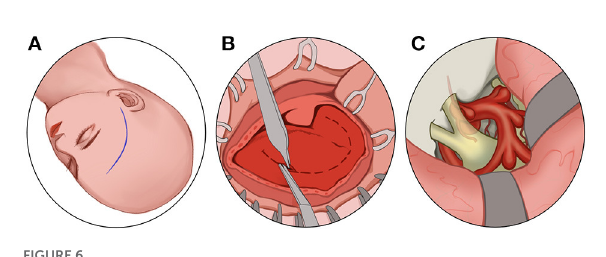
FIGURE6 Transcranial route: (A) Make a frontotemporal pterygium craniotomy via Dolenc route. (B) cut the scalp and temporalis muscle. (C) Grind off the anterior bed and the sphenoid bone and decompress the optic nerve at 270 degrees from superior, medial, and